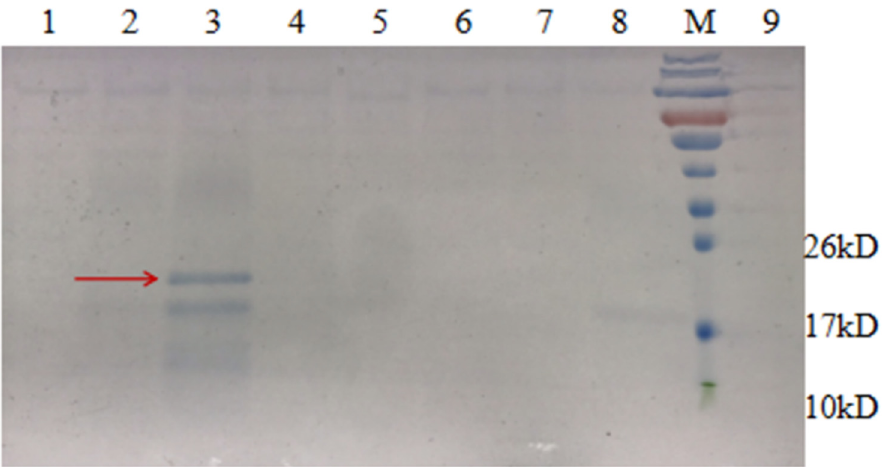
Figure 9. SDS-PAGE (12%) analysis of expression of AMP13 in Pichia pastoris . M, protein molecular weight marker. Lane 3, AMP produced by P. pastoris